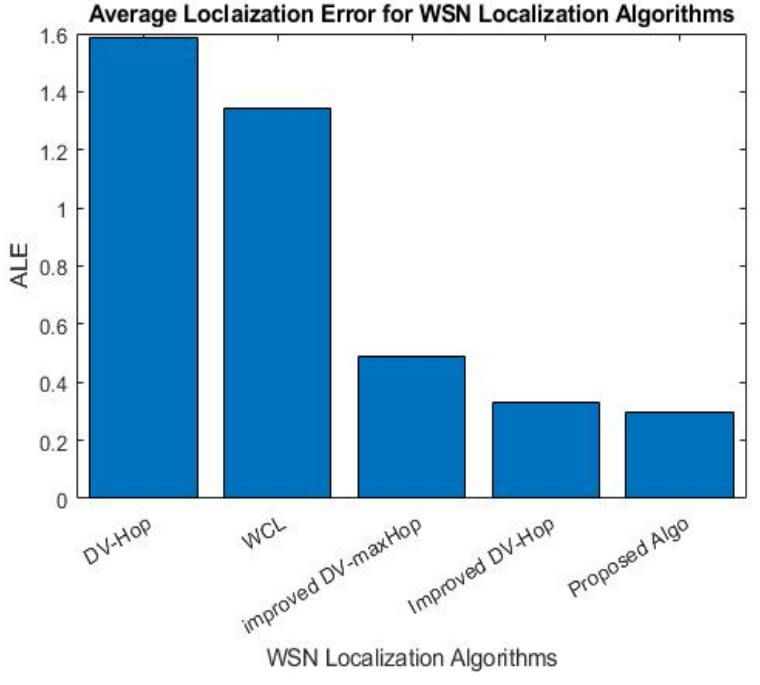
Figure 8. ALE for WSN localization algorithms.